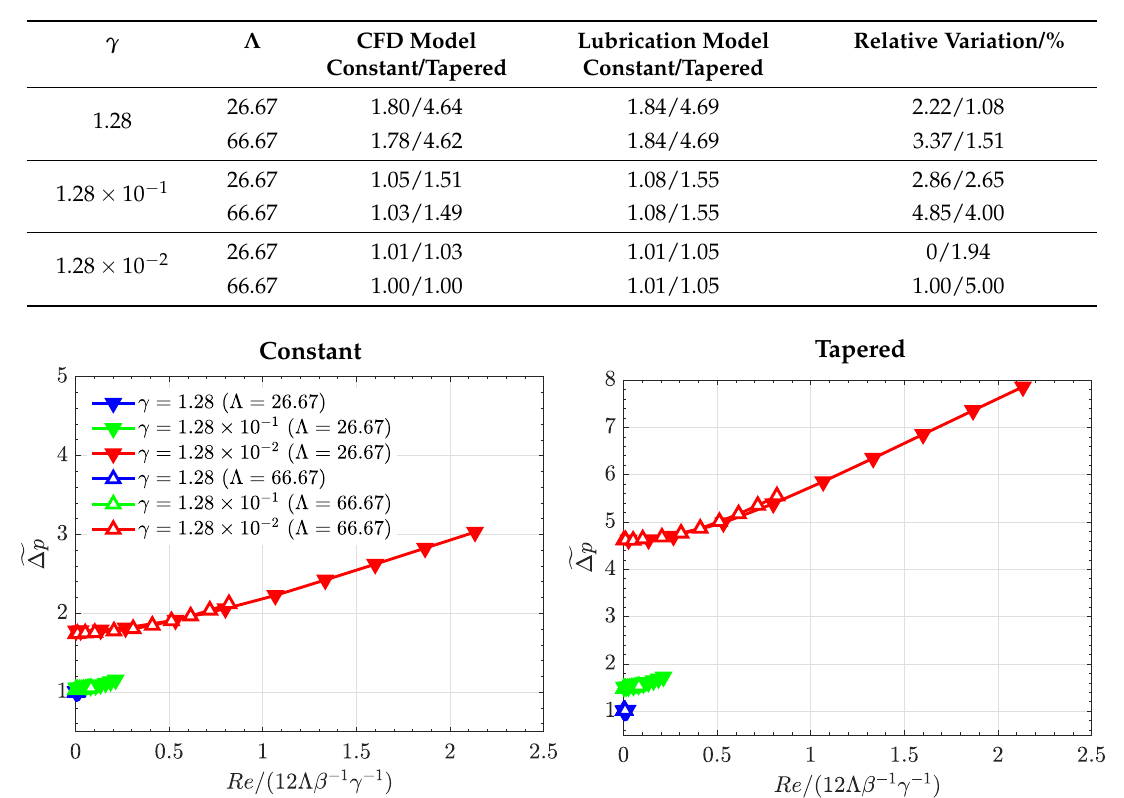
Table 2. Overall pressure drop, (cid:102) ∆ p , predicted by the CFD model and the lubrication model for the constant cross-section and the tapered flow fields corresponding to different values of γ and Λ . Nearly ramped channels were considered for the tapered geometry in the CFD model ( φ = 10 − 2 ) and the lubrication model ( α = 0.99).